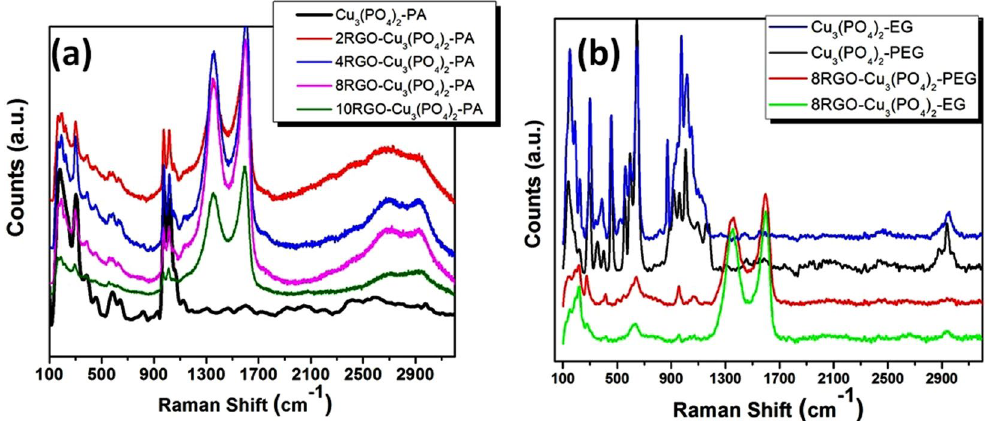
Figure 11. Raman spectra of ( a ) xRGO-Cu 3 (PO 4 ) 2 -PA, ( b ) xRGO-Cu 3 (PO 4 ) 2